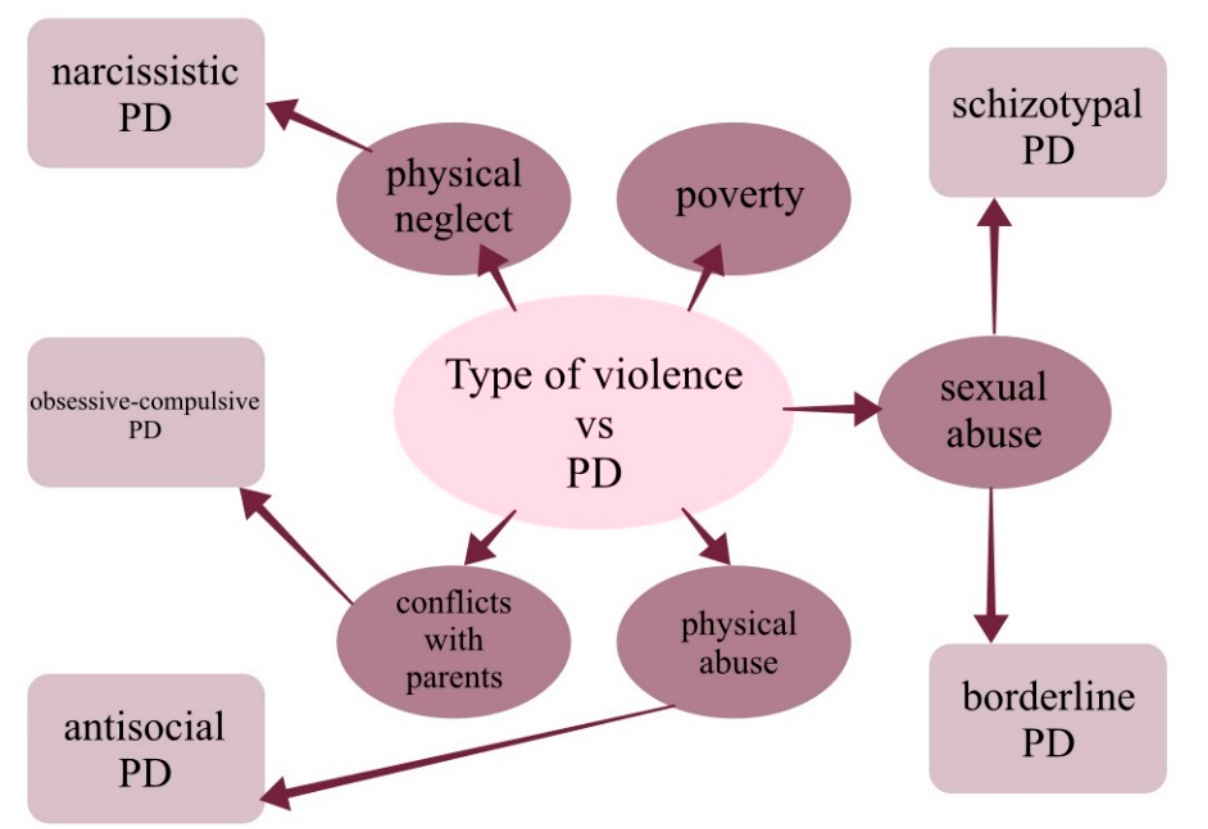
Figure 1. Type of childhood violence vs. type of personality disorder that may occur in adulthood. Abbreviations: PD—personality disorder.